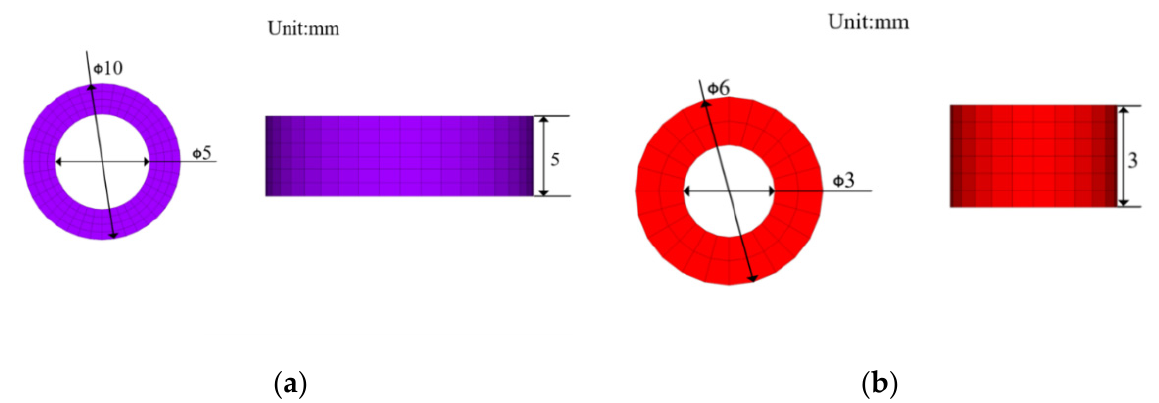
Figure 4. Coil size diagram. ( a ) Excitation coil; ( b ) Detection coil.